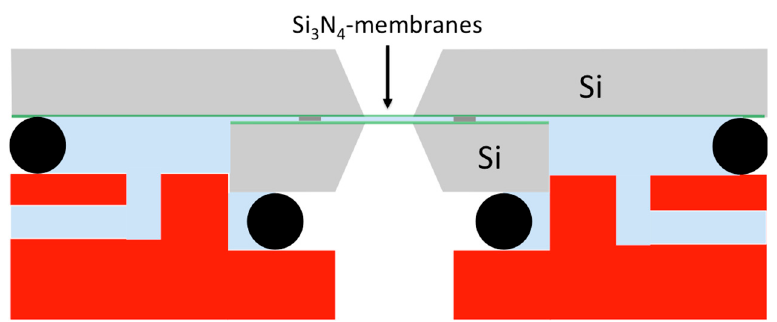
Figure 1. Schematic of LCTEM holder design (not to scale) in cross section. Black circles indicate O-rings sealing the water bearing tubes from the microscope vacuum. The electron transparent volume is given by the lateral extensions of the silicon nitride membranes and the spacers separating the two chips.